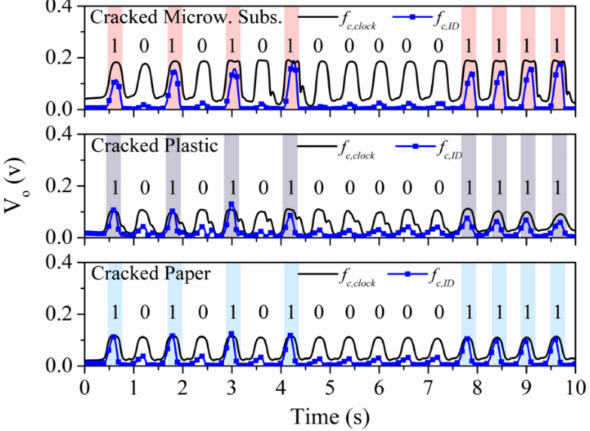
Figure 24. Clock and ID signals inferred by reading a microwave substrate, plastic, and paper-based encoder with cracks in all patches. Reprinted with permission from [26]. Copyright 2020